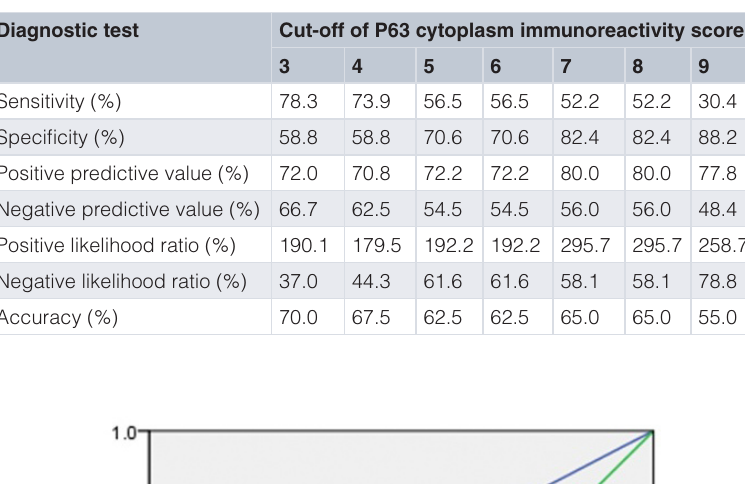
Table 5. Predictor diagnostic value of P63 in the cytoplasm for diagnosing Basal- like type TNBC.